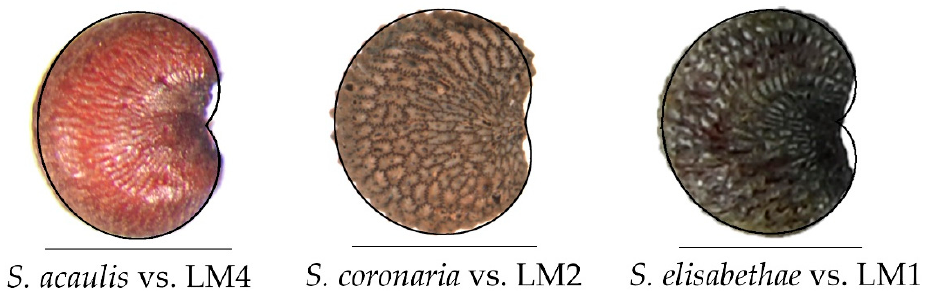
Figure 9. Representative images of the group of rugose seeds. The mean values of J index obtained with the models shown are of 91.0 for S. acaulis with LM4; 93.5 for S. coronaria with LM1 and 90.1 for S. elisabethae with LM1.